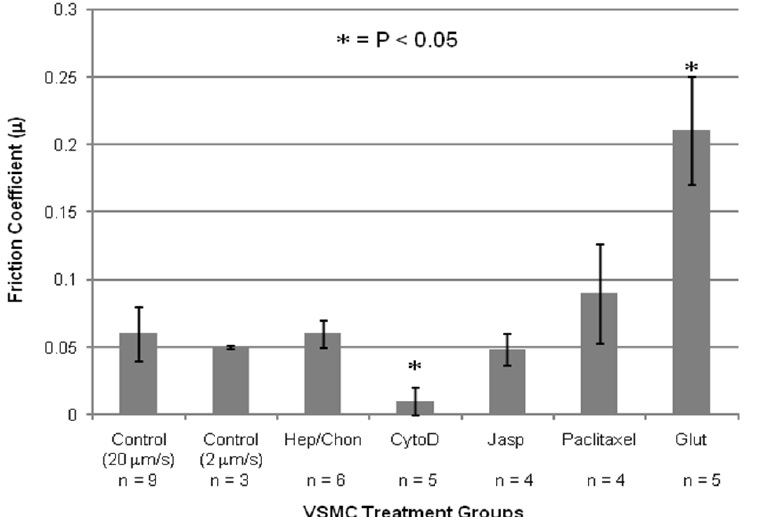
Figure 2. VSMC coefficients of friction. Data are presented as mean ±SD. Control untreated cells were tested at 20  m/s and 2  m/s scanning speeds. The treatment groups were: Hep/Chon = heparinase/chondroitinase treatment, CytoD = cytochalasin D treatment, Jasp = jasplakinolide treatment, Paclitaxel treatment, and Glut = Glutaraldehyde